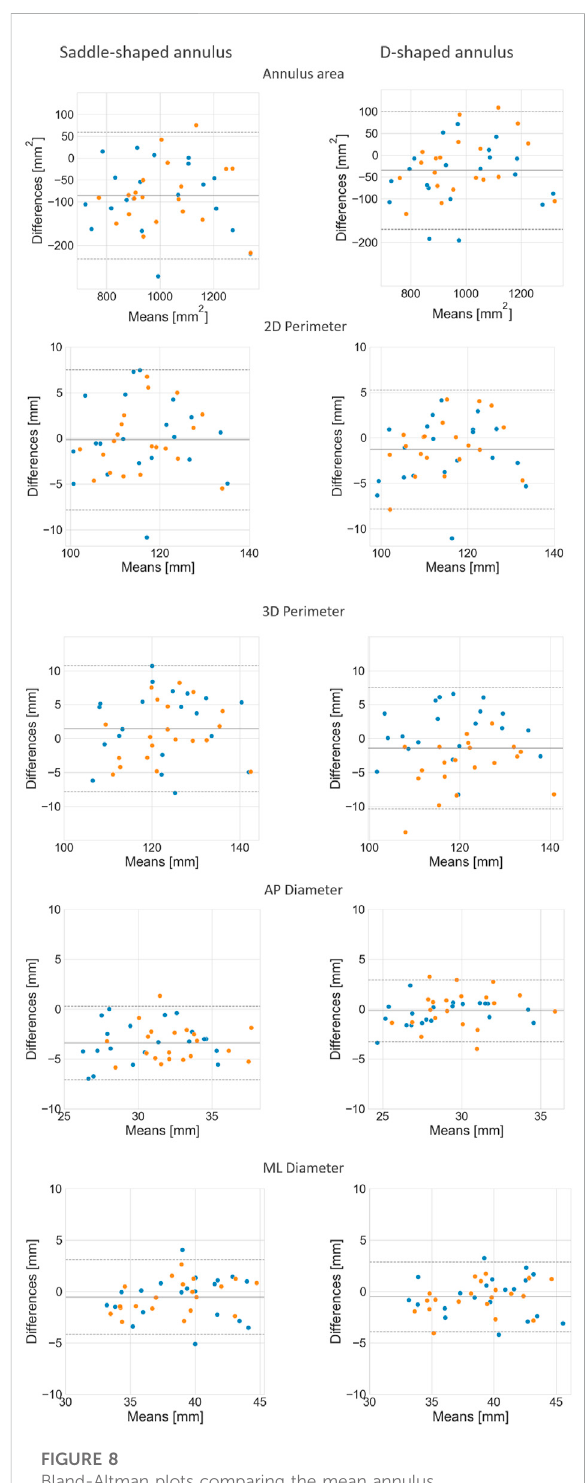
FIGURE 8 Bland-Altman plots comparing the mean annulus measurements obtained for the three observers and those calculated from the automatically detected landmarks, for both the saddle- (left) and D-shaped (right) con fi